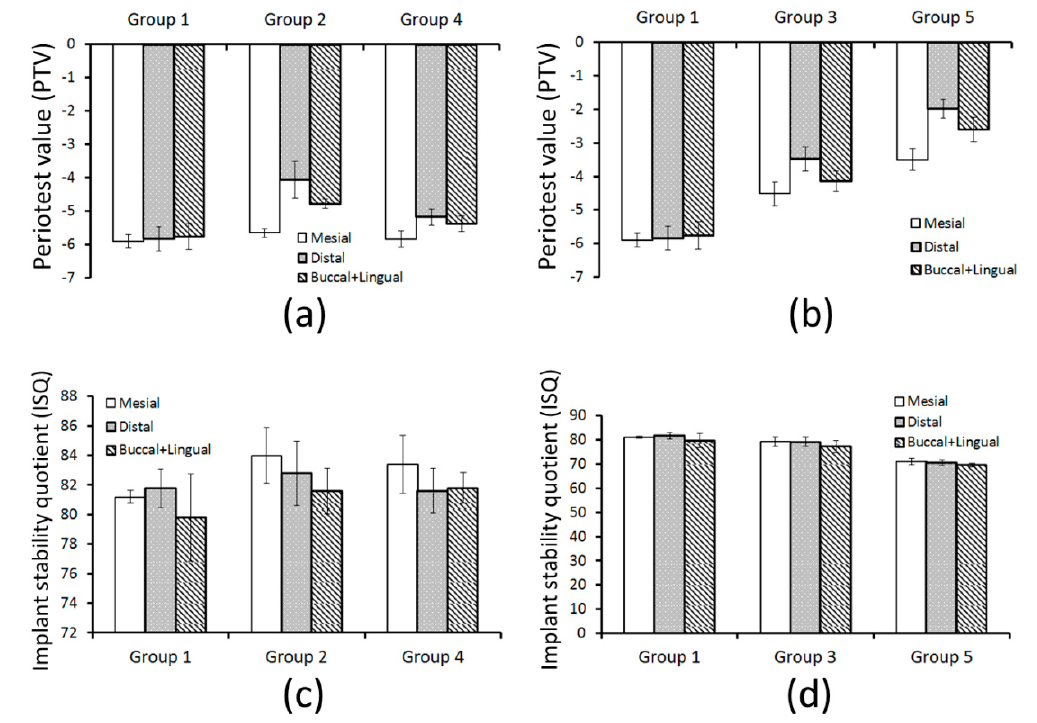
Figure 4. PTV ( a , b ) and ISQ ( c , d ) measurements of Groups 1, 2 and 4 and Groups 1, 3 and